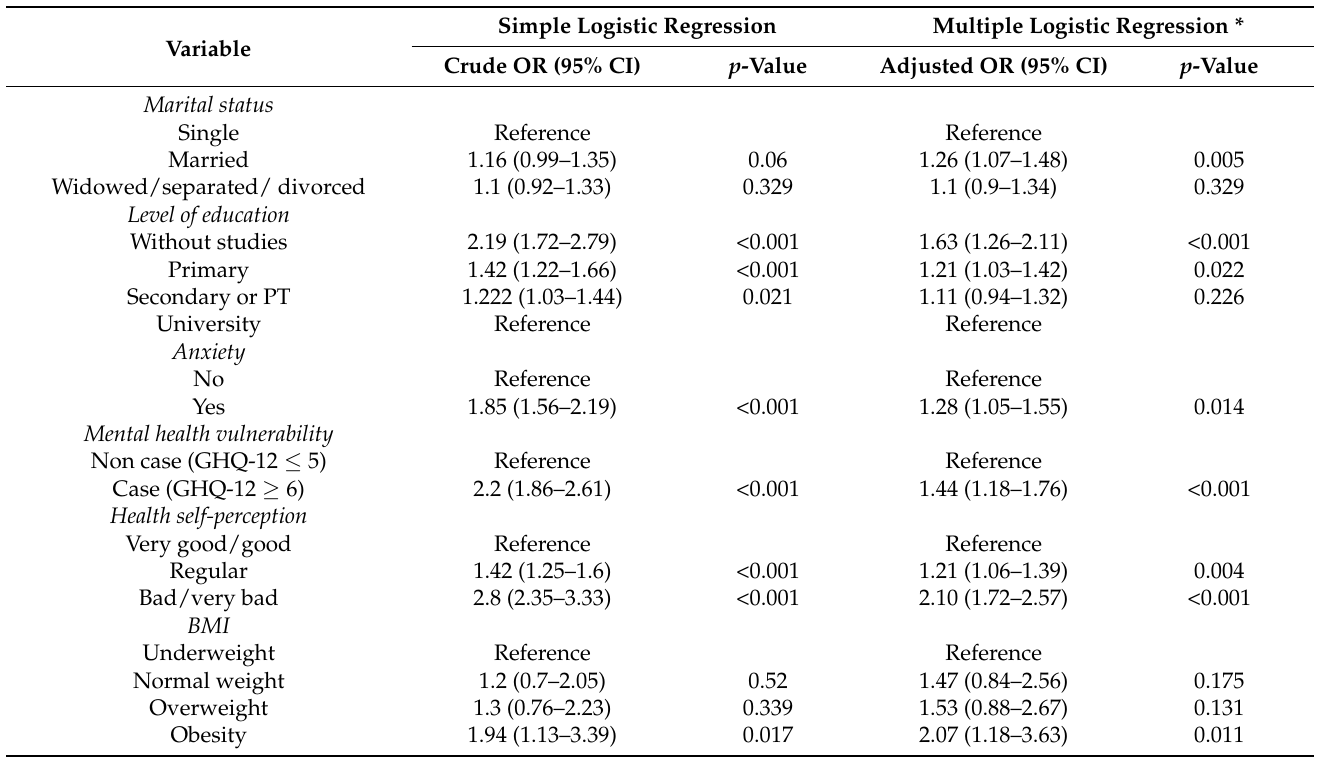
Table 4. Logistic regression model for the association between the low level of physical activity and sociodemographic and health characteristics of Spanish pre-elderly.